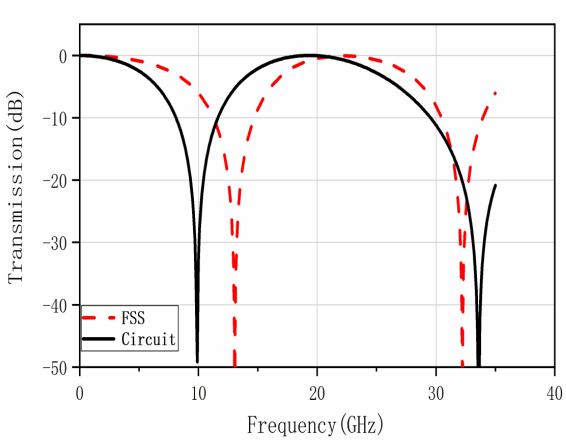
Figure 4. Model of the proposed dual band-stop